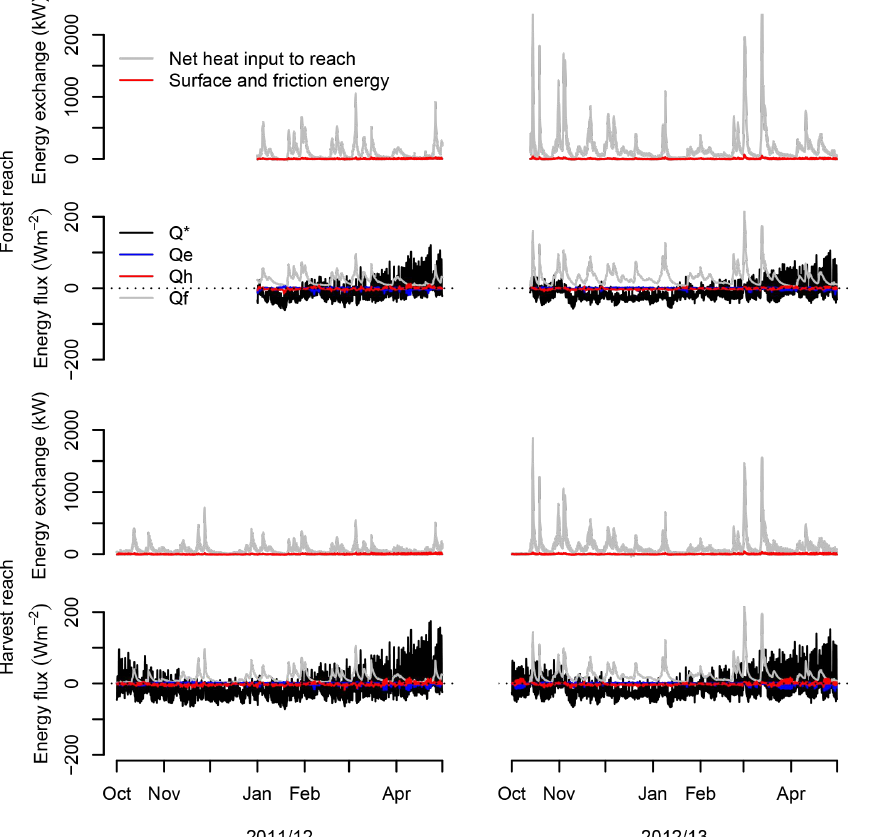
Fig. 4. Time series of hourly energy budget components (net radiation, Q ∗ ; latent heat flux, Q e ; sensible heat flux, Q h ; and heat addition due to friction, Q f ) for the forest and harvest reaches for 2011/2012 and 2012/2013. Note the difference in units and scales of the plots comparing net heat input to the reach with surface and friction energy exchanges, and the plots showing the energy fluxes of net radiation, sensible heat, latent heat, and friction.